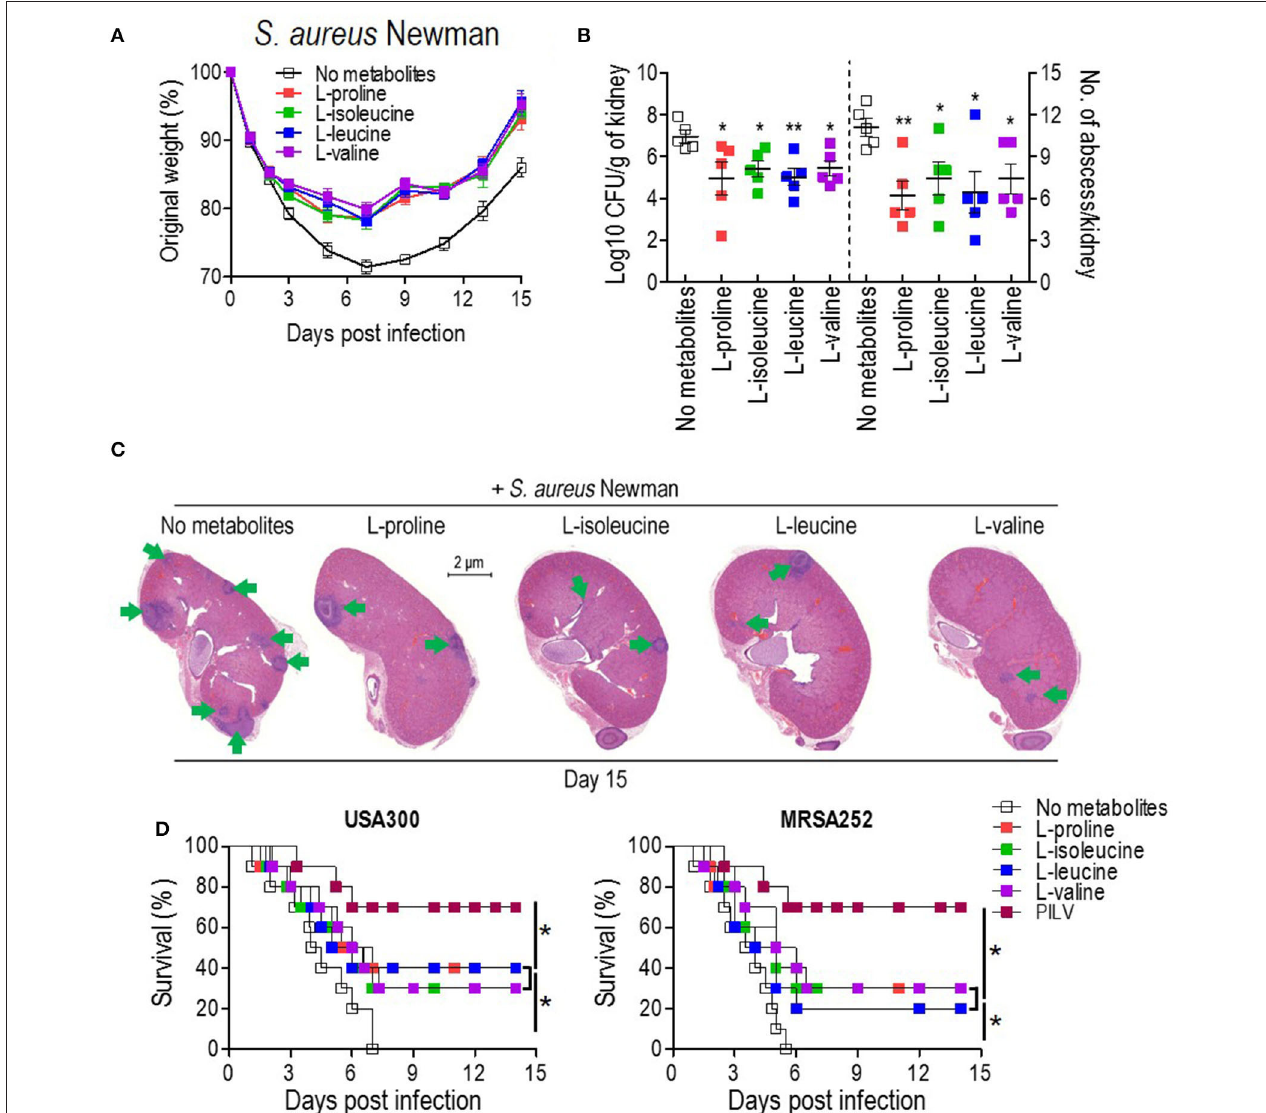
FIGURE 3 | The administration of single metabolite or of a metabolite combination (named PILV) protects mice against S. aureus bloodstream infection. (A–C) Treatment with each metabolite, L-proline, L-isoleucine, L-leucine, or L-valine, rescued body weight loss (A) and reduced renal bacterial loads and abscess numbers (B,C) in mice infected by S. aureus Newman strain. Weight was recorded daily and reported as % of initial weight. Fifteen days post-infection, kidneys ( n = 5) were removed and either ground for enumerating CFU/g tissue or fixed for counting surface abscesses (B) . Fixed kidneys were additionally thin sectioned and then stained with hematoxylin and eosin (H&E) for internal abscesses (C) . Green arrows point to internal abscesses in the kidney. (D) Treatment with single metabolites or a metabolite combination (PILV) protected mice (BALB/c, n = 20) against lethal bloodstream infection with S. aureus USA300 and MRSA252. Survival was monitored over 14 days. Data are represented as means ± SEM. * P < 0.05 and ** P < 0.01 (two-tailed Mann–Whitney